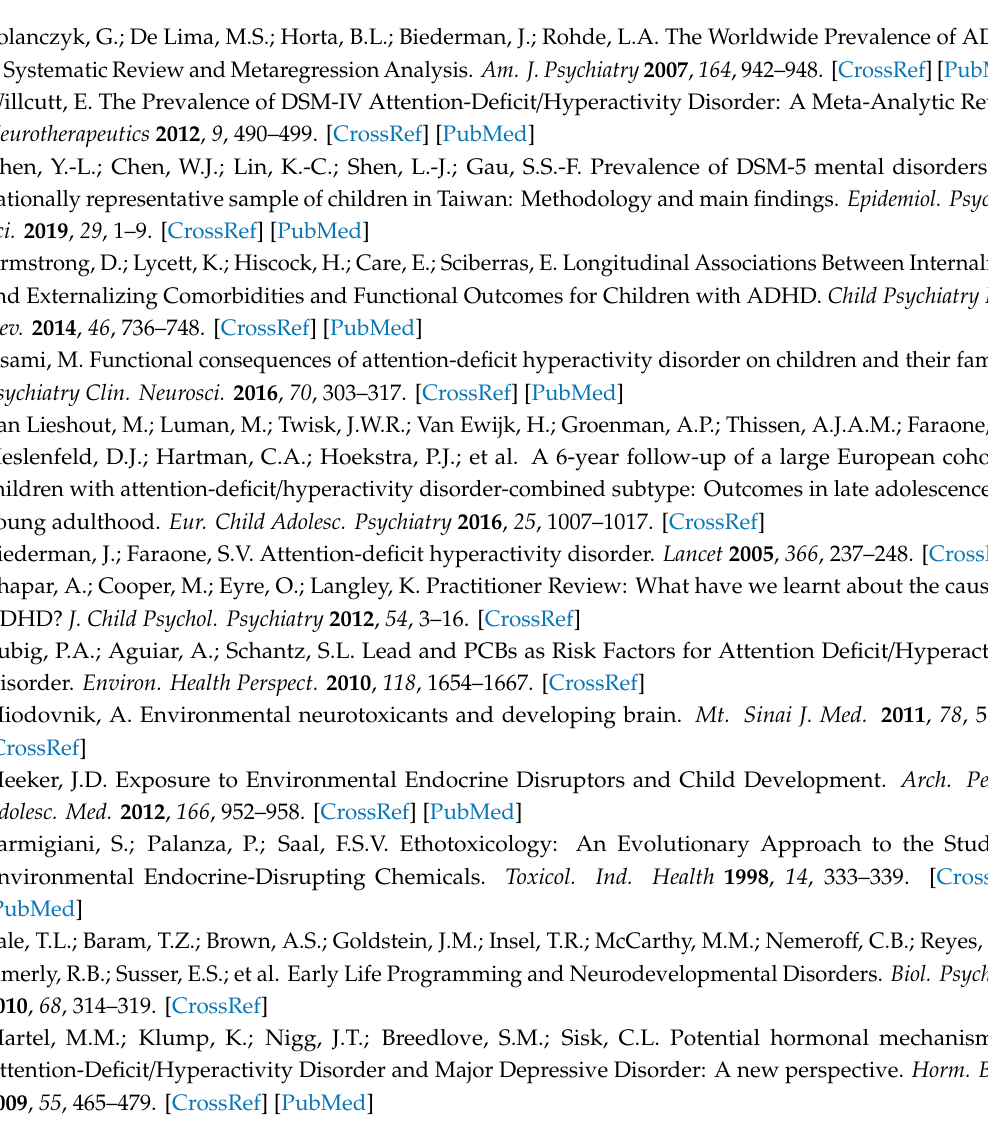
Table S1: Correlations of EDCs in boys and in girls, Table S2: Correlations of gonadal hormone in boys and in girls, Table S3: Correlations of EDCs and levels of gonadal hormone for boys, Table S4: Correlations of EDCs and levels of gonadal hormone for girls, Table S5: Correlations of levels of gonadal hormone and symptoms of ADHD for boys. Table S6: Correlations of levels of gonadal hormone and symptoms of ADHD for